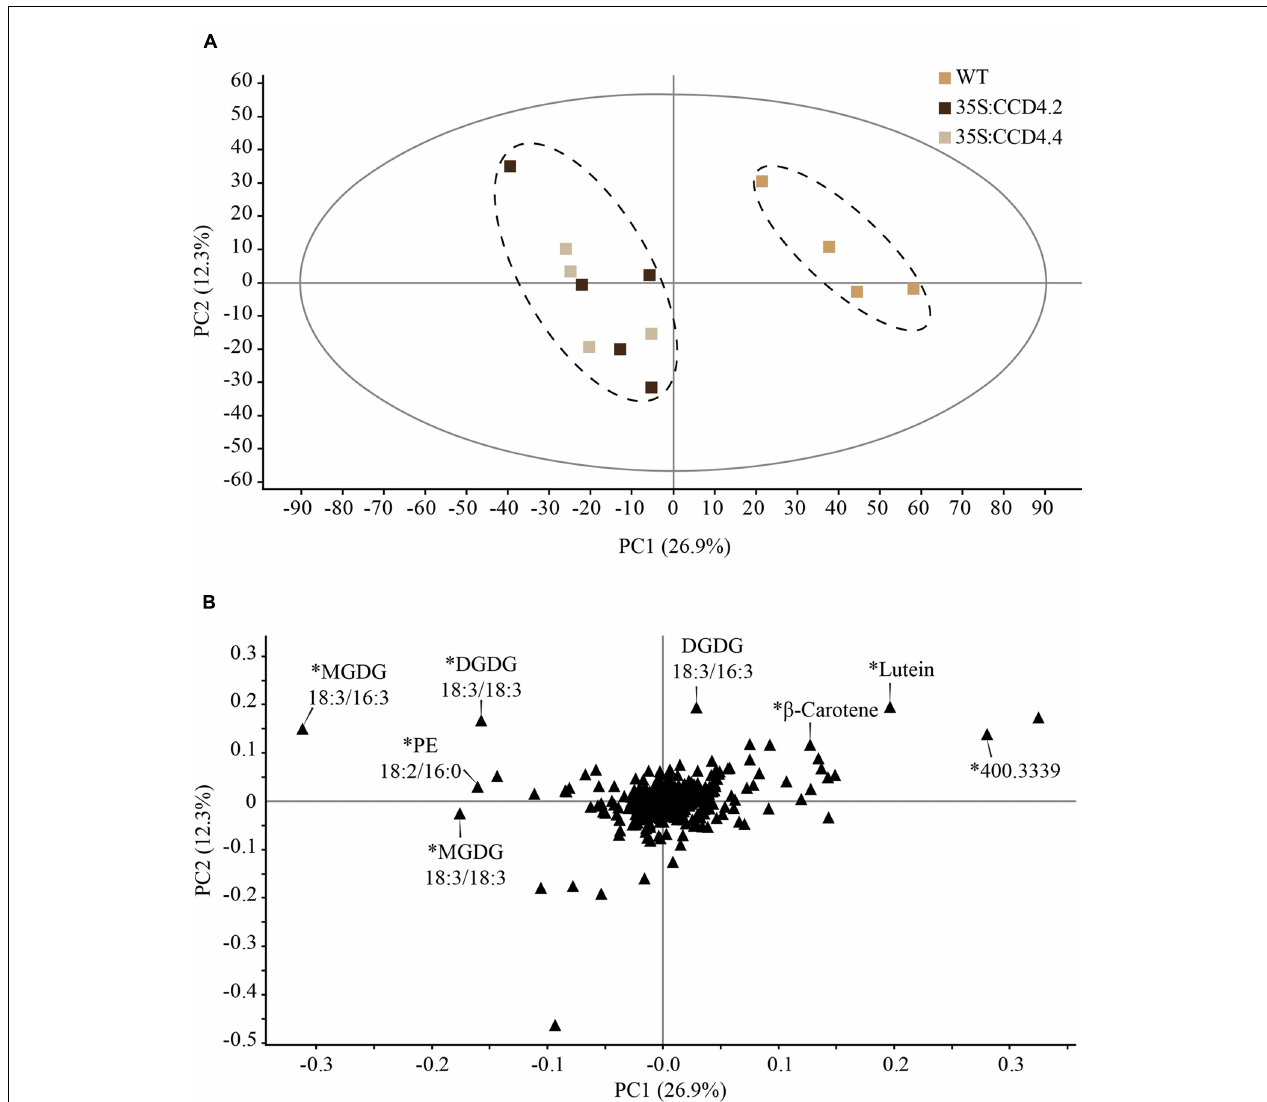
FIGURE 4 | Constitutive expression of CCD4 resulted in a distinct lipid profile during dark-induced senescence in leaves when compared with WT. (A) Detached leaves were placed in darkness for 8 days prior to lipid extraction ( n = 5 ). Lipids were analyzed by ultra-high pressure liquid chromatography-atmospheric pressure chemical ionization-quadrupole time of flight mass spectrometry. Discrimination was evaluated with a partial least squares-discriminant analysis in which outlying samples were removed prior to data processing. (B) Compounds responsible for the difference between CCD4 complemented lines and WT are indicated on the loading plot. ∗ Statistically significant according to Student’s t -test (unpaired heteroscedastic, two-tailed). PC, principal